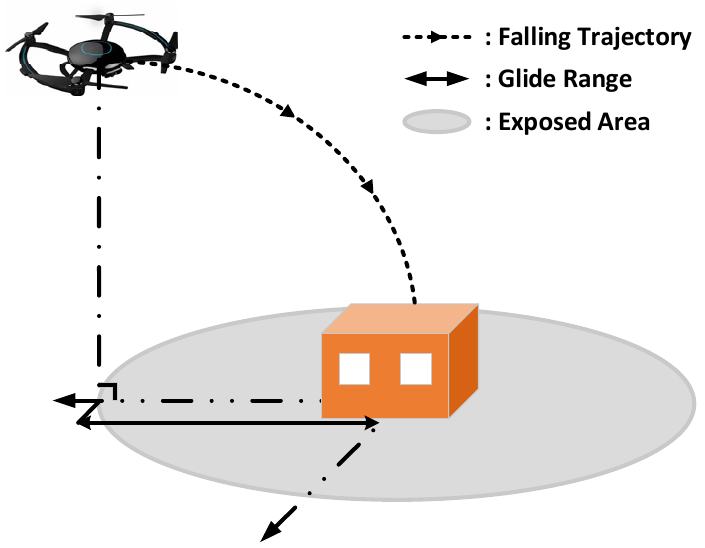
Figure 4. Exposed area of ground element.